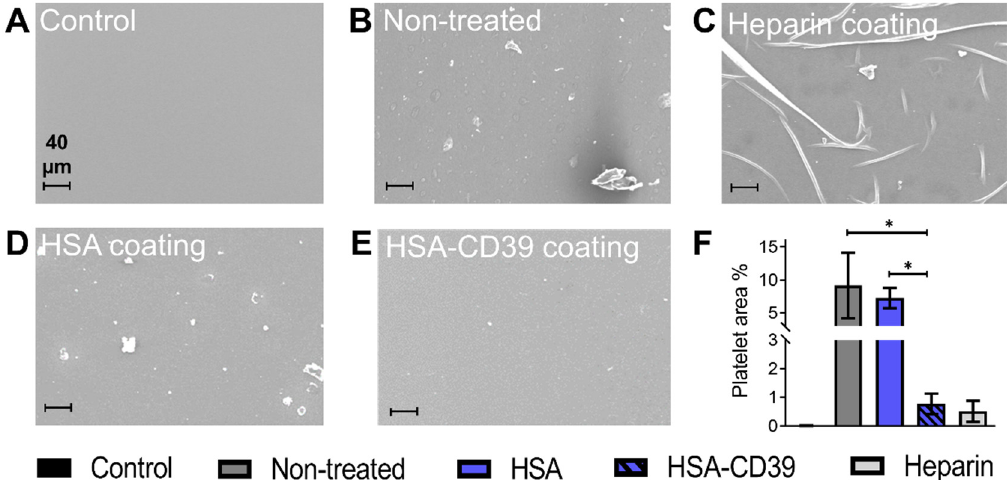
Figure 9. HSA-CD39 coated onto PCV tubes reduces blood cell adhesion as analysed in a modified chandler loop model. SEM analysis of PVC tubes to visualise the adhesion of platelets after circulation with human whole blood. ( A ) PVC tube without blood contact. ( B ) Non-treated PVC tube incubated with blood. ( C ) Commercially available heparin coating (Carmeda BioActive Surface ® , Medtronic, Ireland). ( D ) HSA-coated PVC tube. ( E ) HSA–CD39-coated PVC tube (magnification: 250x). Less adhesion of platelets was measured in HSA–CD39-coated tubes as compared to HSA or non-treated controls. ( F ). Quantitative analysis of the percentage of area covered by platelets was performed using ImageJ (% activated platelets ± SD, * p < 0.05). Values of at least 3 independent experiments are depicted.